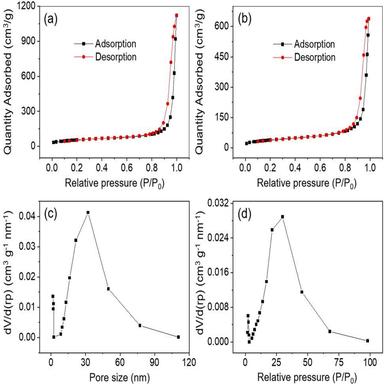
The N2 adsorption & desorption isotherms of (a) β-type Co(OH)2 microflowers and (b) β-phase Co(OH)2 microclews, and the curves of pore size distribution for (c) β-Co(OH)2 microflowers and (d) β-Co(OH)2 microclews.